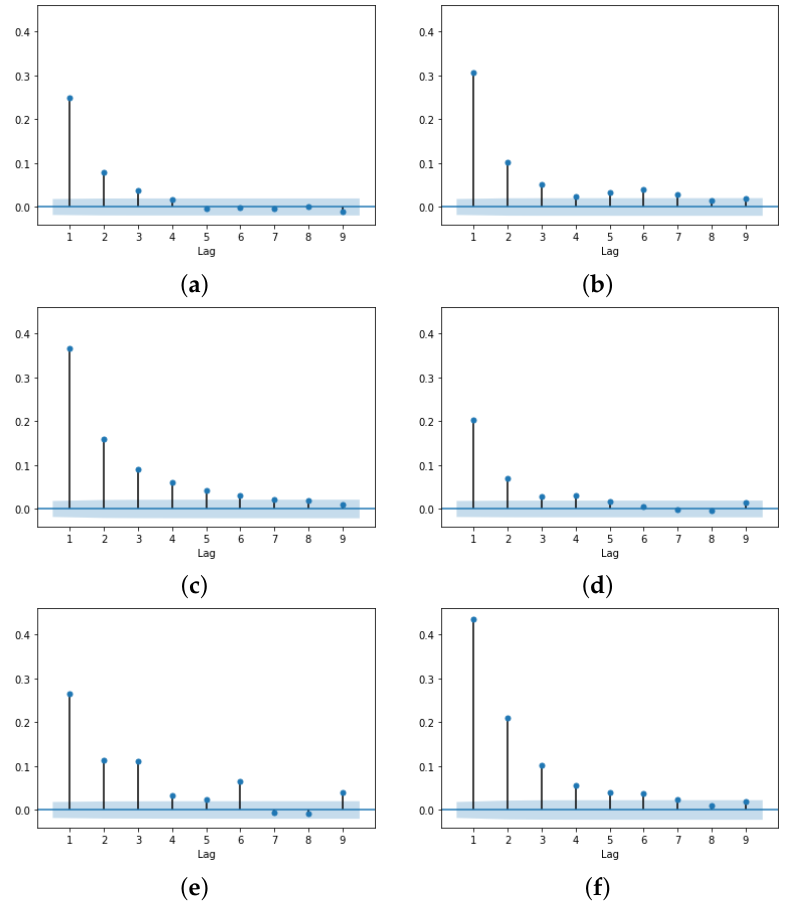
Figure 9. Spread autocorrelation. ( a ) CDA. ( b ) FBA (0.5). ( c ) FBA (1.0). ( d ) HVCDA. ( e ) FBA (1.5). ( f ) FBA